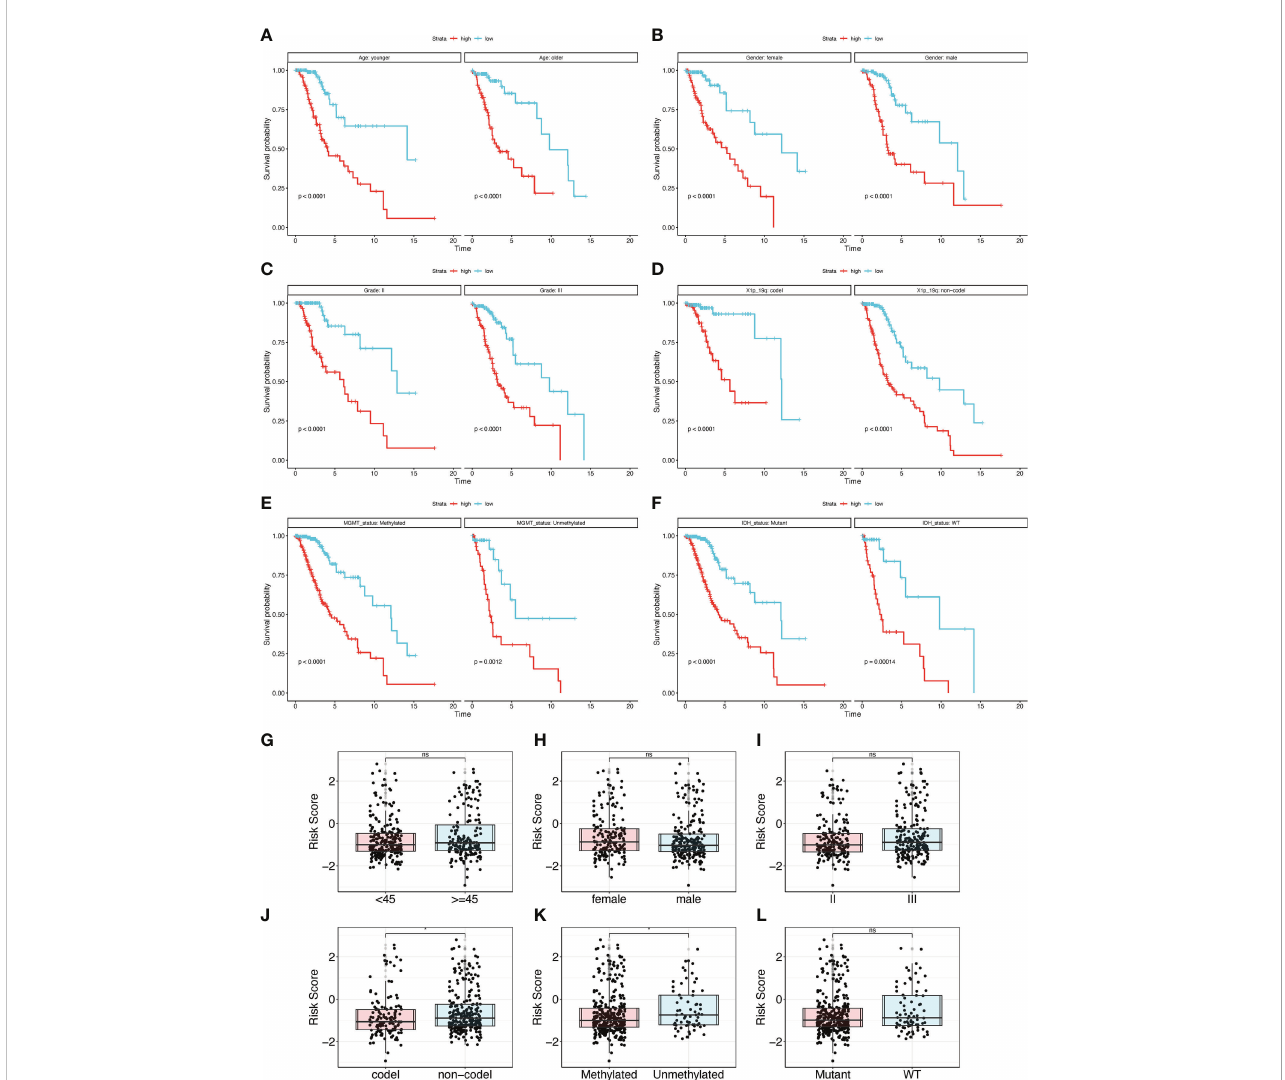
FIGURE 5 Subgroup analysis of the TPR signature for clinical features. (A-F) The overall survival rate of different subgroups in the TCGA-LGG cohort, including Age (A) , Gender (B) , Grade (C) , 1p19q status (D) , MGMT (E) , and IDH status (F) ; 1p19q status: the coding and noncoding deletion status in the short arm of chromosome 1 and the long arm of chromosome 19; MGMT status: methylation status of MGMT ; IDH status: IDH1 mutant and wildtype. (G-I) The risk score between different clinical subgroup features in the TCGA-LGG cohort, including Age (G) , Gender (H) , Grade (I) , 1p19q (J) , MGMT (K) , and IDH status (L)